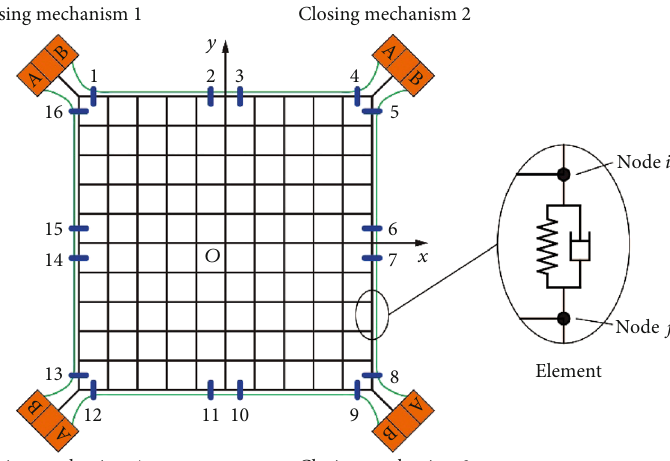
Figure 4: Con fi guration of the tether-net.